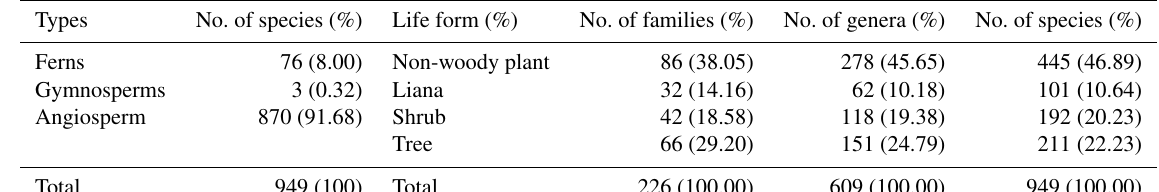
Table 1. Composition of plants of rubber plantations in the GMS.